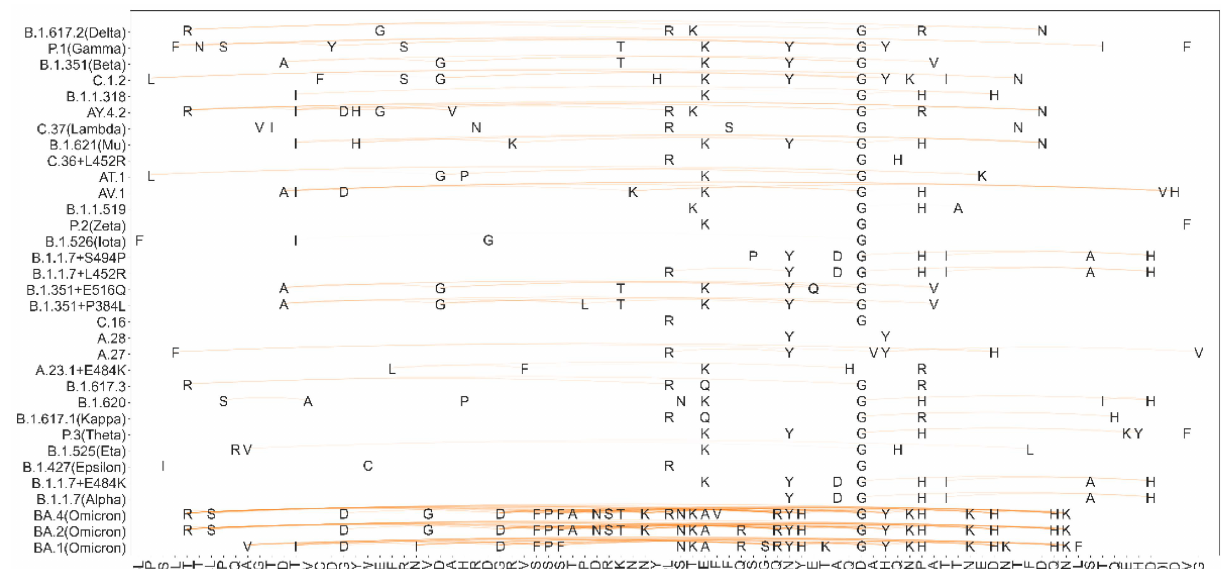
Figure 3. The co-conservation of mutation sites in popular